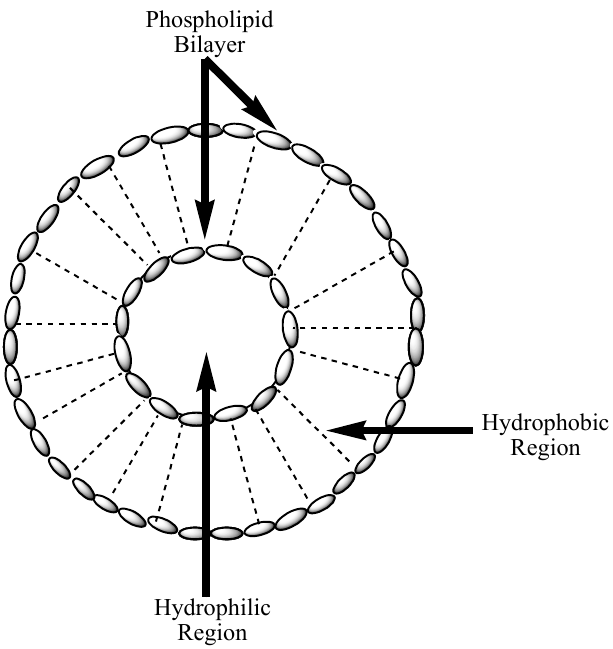
Figure 4. Schematic diagram of nanoliposomes.